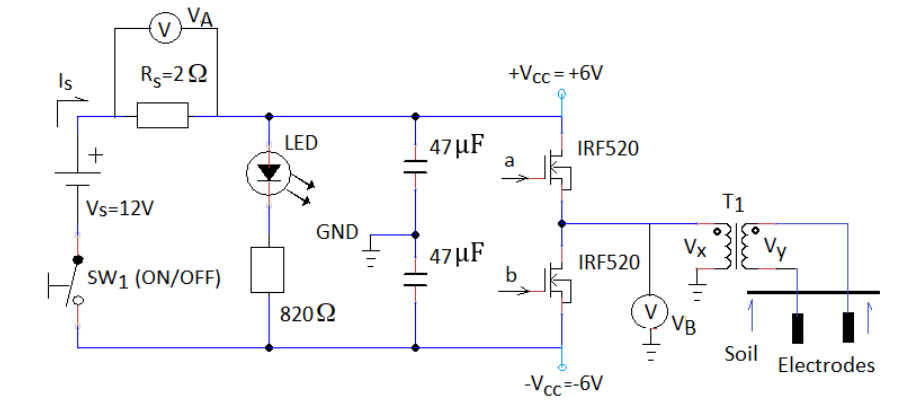
Figure 3. The single-phase DC-to-AC converter followed by a transformer. This circuit receives complementary switching signals at the pins a and b , which are generated by the circuit shown in Figure